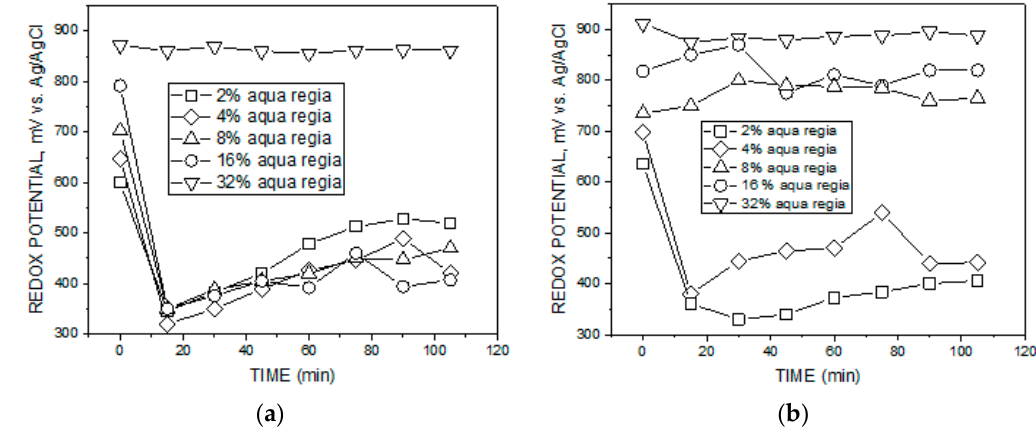
Figure 3. Aqua regia redox potential prior to raw material exposure (t = 0) and during the WPCB batch leaching tests (L1–L5) at temperatures ( a ) 40 °C and ( b ) 80 °C.